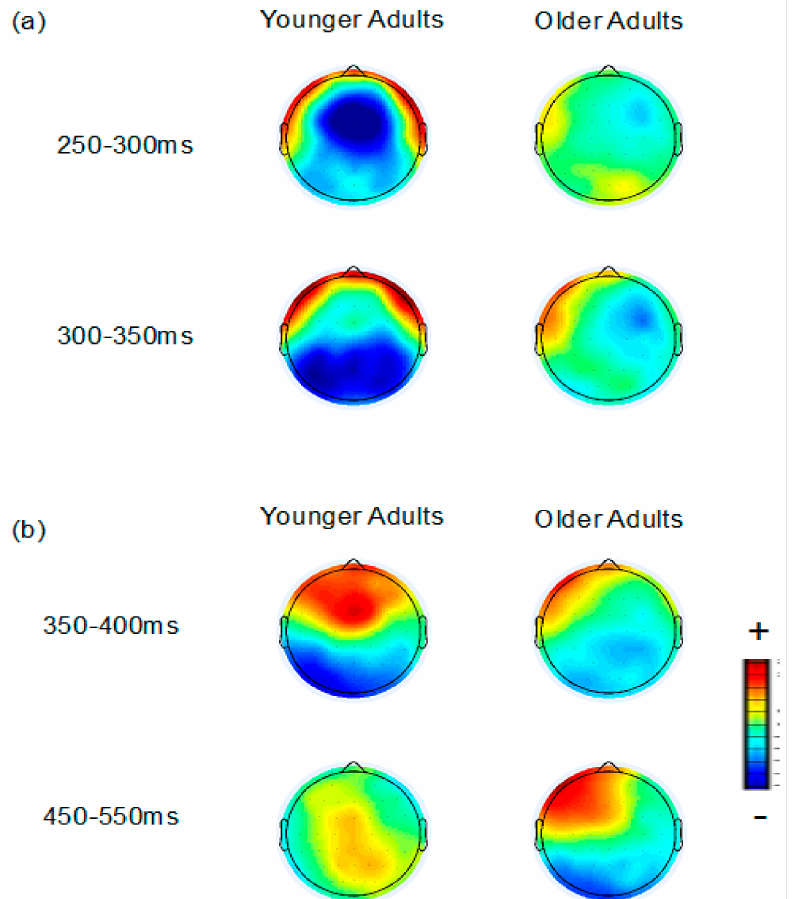
Figure 2. 2D topography maps for incorrect minus correct feedback demonstrating the distribution of the ( a ) FN and ( b ) frontal P3 in younger and older adults. Blues represent greater negativity for incorrect than correct feedback and reds represent greater positivity for incorrect than correct